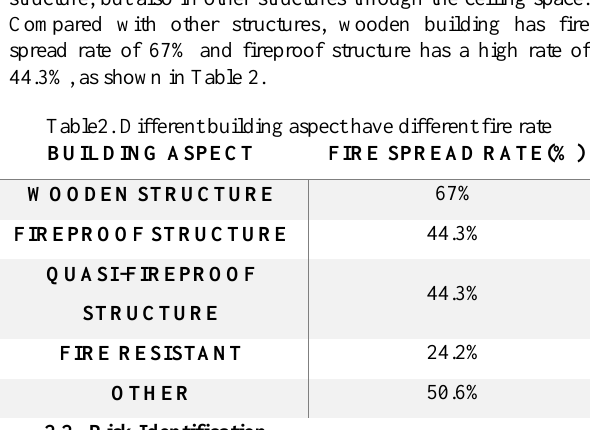
Table2. Different building aspect have different fire